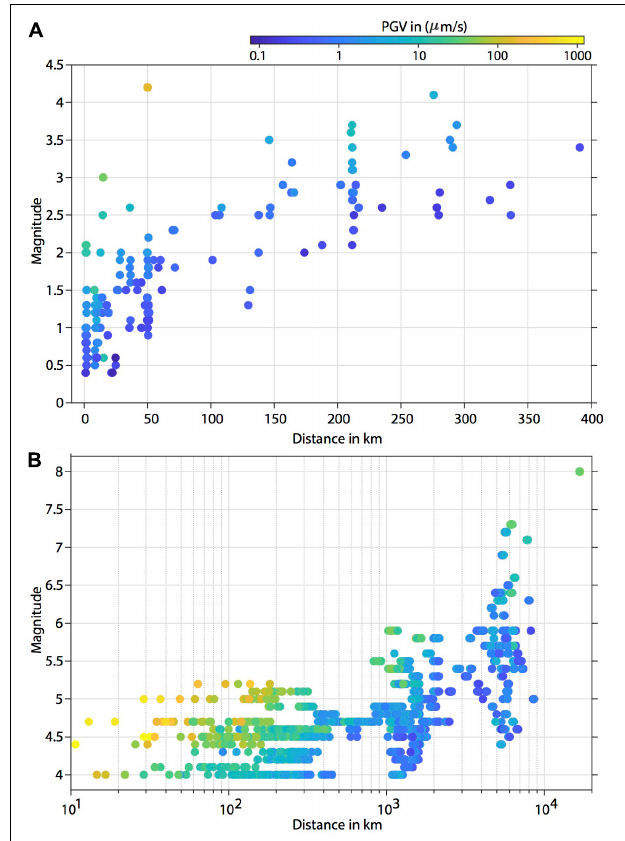
FIGURE 10 | Observed vertical peak ground velocity (PGV V ) as a function of magnitude and distance at (A) our test site in Grimisuat, Switzerland, and (B) across the NSSN. Each circle in the plot represents the observed maximum amplitude motion at a station following a single earthquake. In total 210 events for the station in Switzerland and 194 events for NSSN are plotted using the 6-month data from the catalogs. Sources of earthquake catalogs: SED in Switzerland (A) , NSC and USGS for stations in Nepal (B)